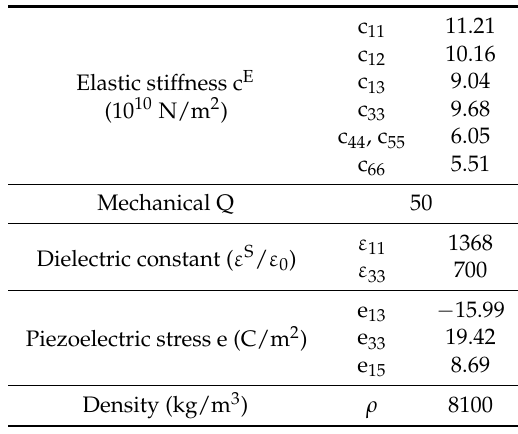
Table 3. Material properties of PMN-32%PT used in FEA